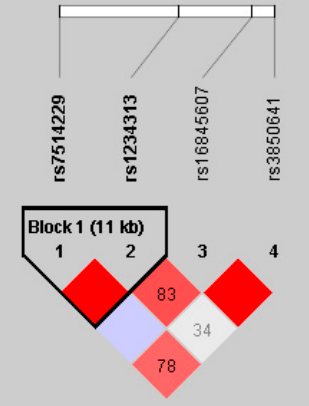
Figure 1. Linkage disequilibrium (LD) block of TNFSF4 from controls in the Hapmap CHB data.